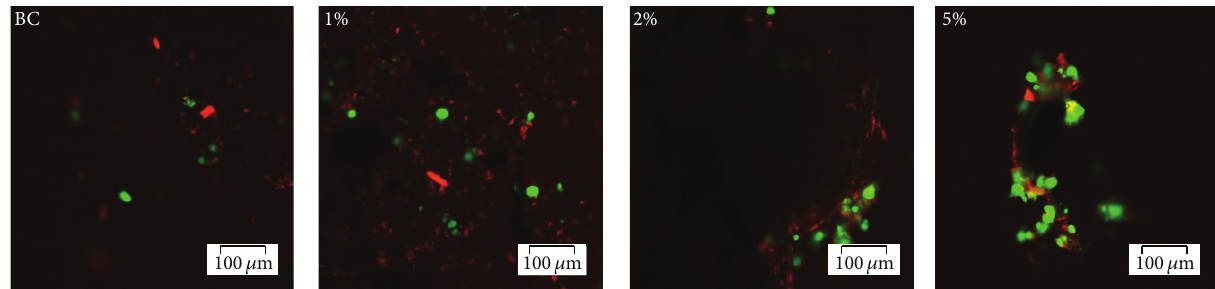
Figure 8: Confocal fluorescence microscopy micrographs revealing live and dead cells on BC, BC/magnetite 1%, BC/magnetite 2%, and BC/magnetite 5%, after 24 h of